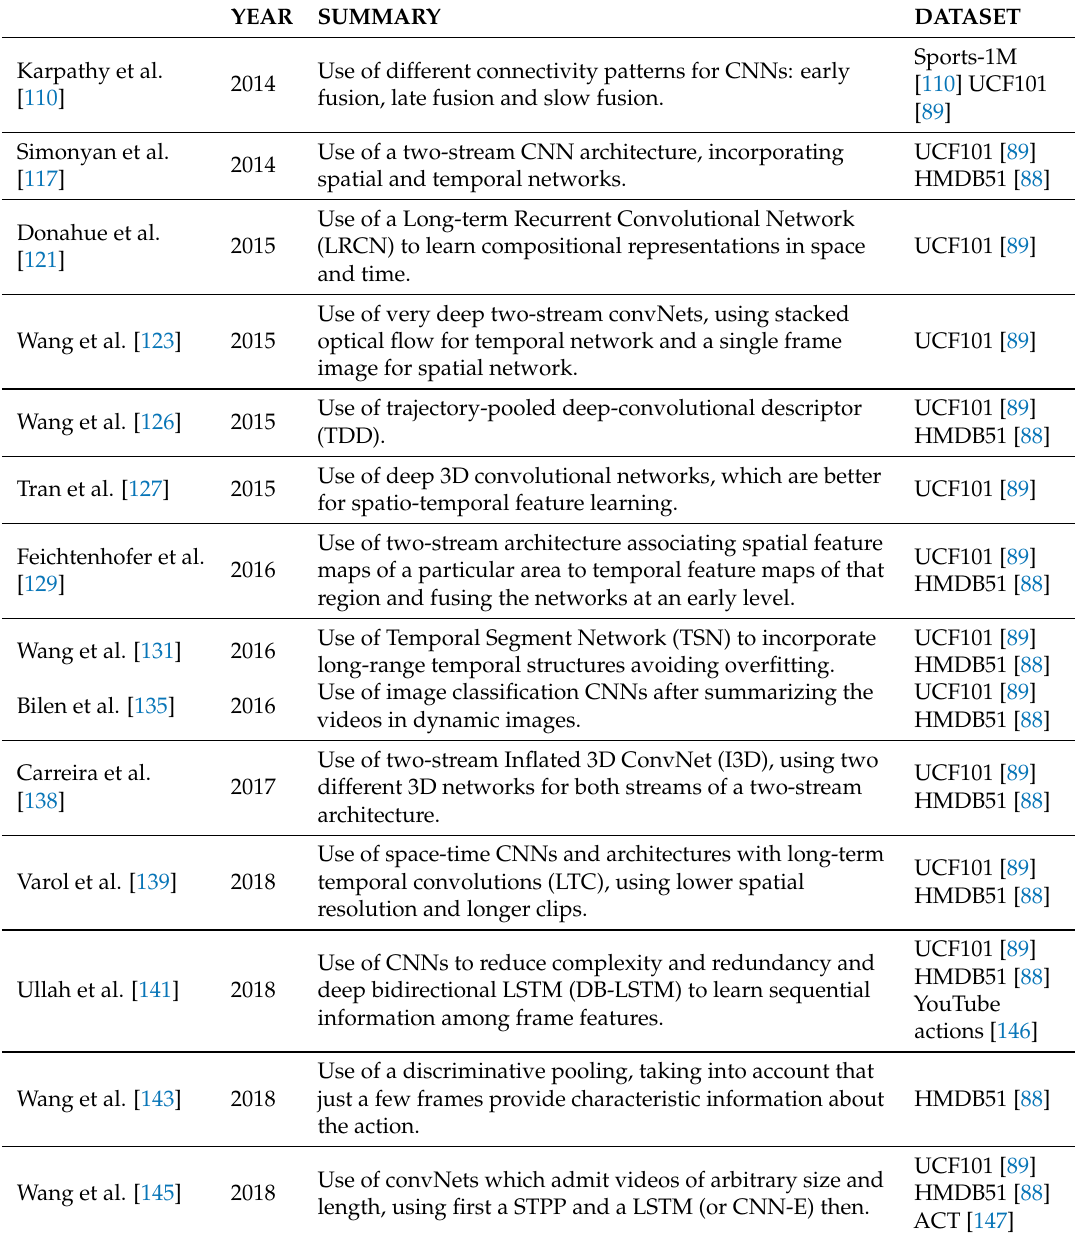
Table 3. Summary of deep learning based